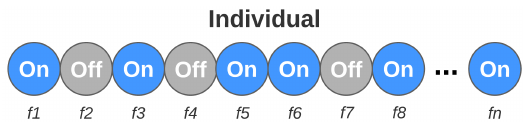
Figure 9. Individual composition in the feature selection step.